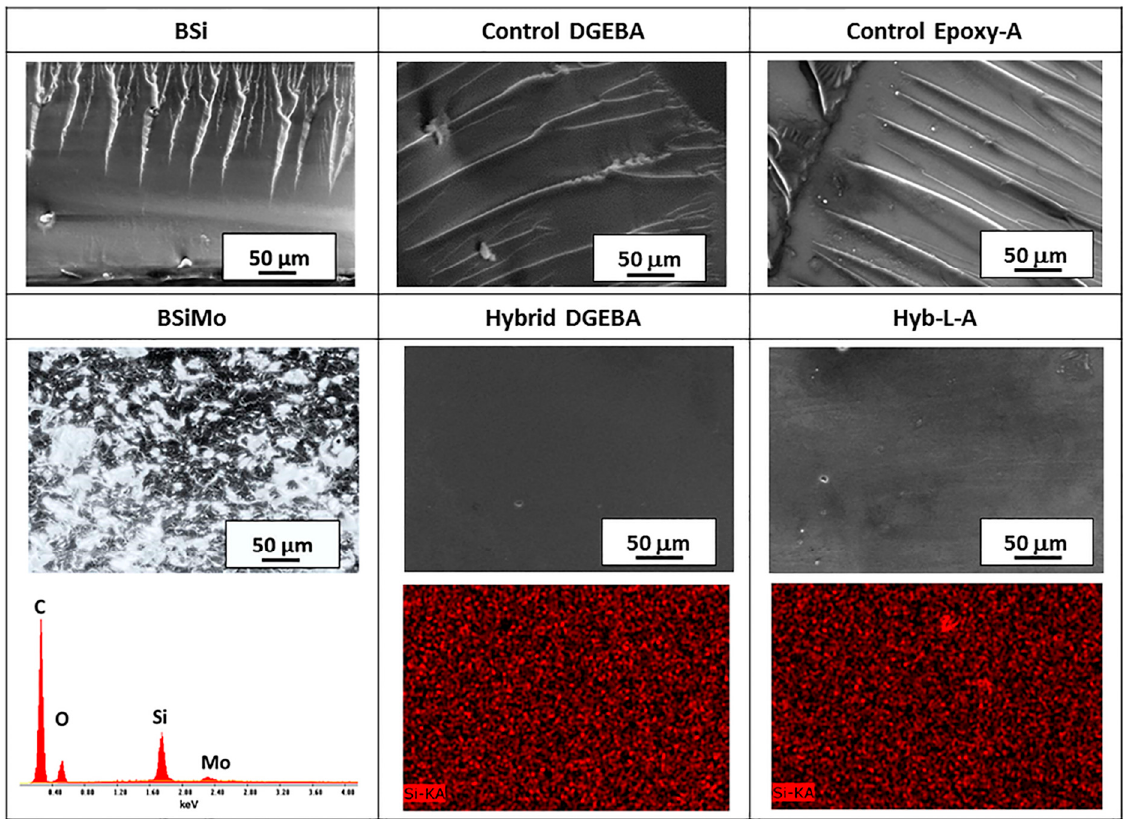
Figure 4. SEM micrographs of the different hybrid systems produced, compared with control systems.